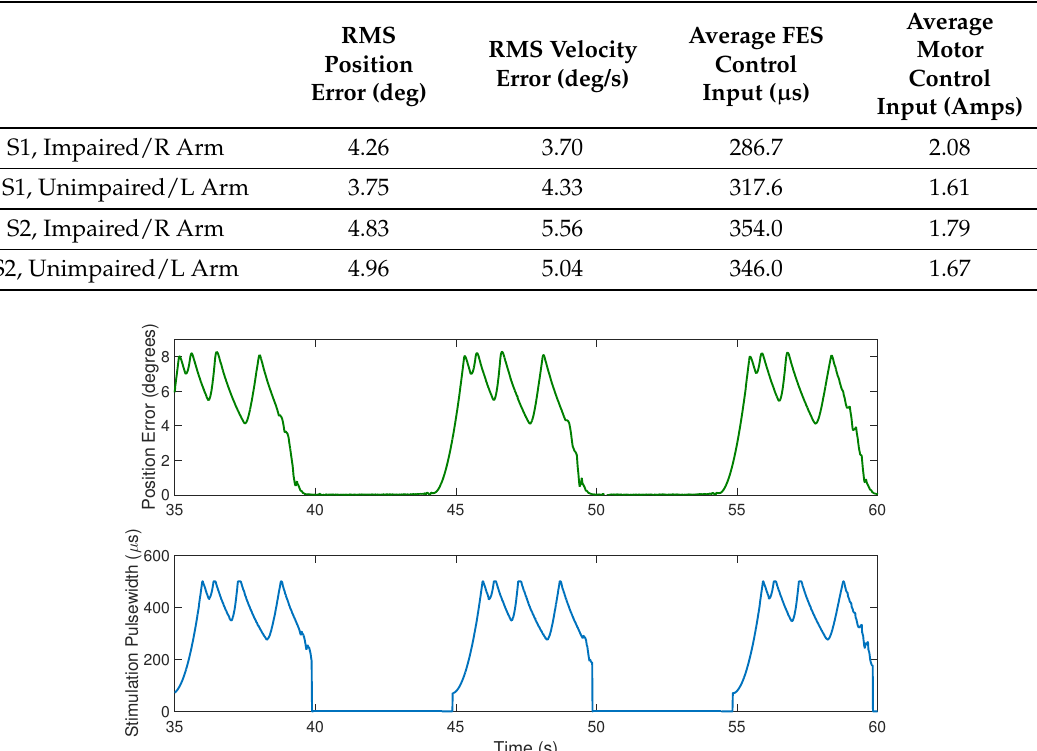
Table 1. Average position and velocity errors, FES control input, and motor control input for both arms (one impaired, one unimpaired) for both subjects. S1 and S2 denote Subjects 1 and 2; R and L denote the right and left arms.